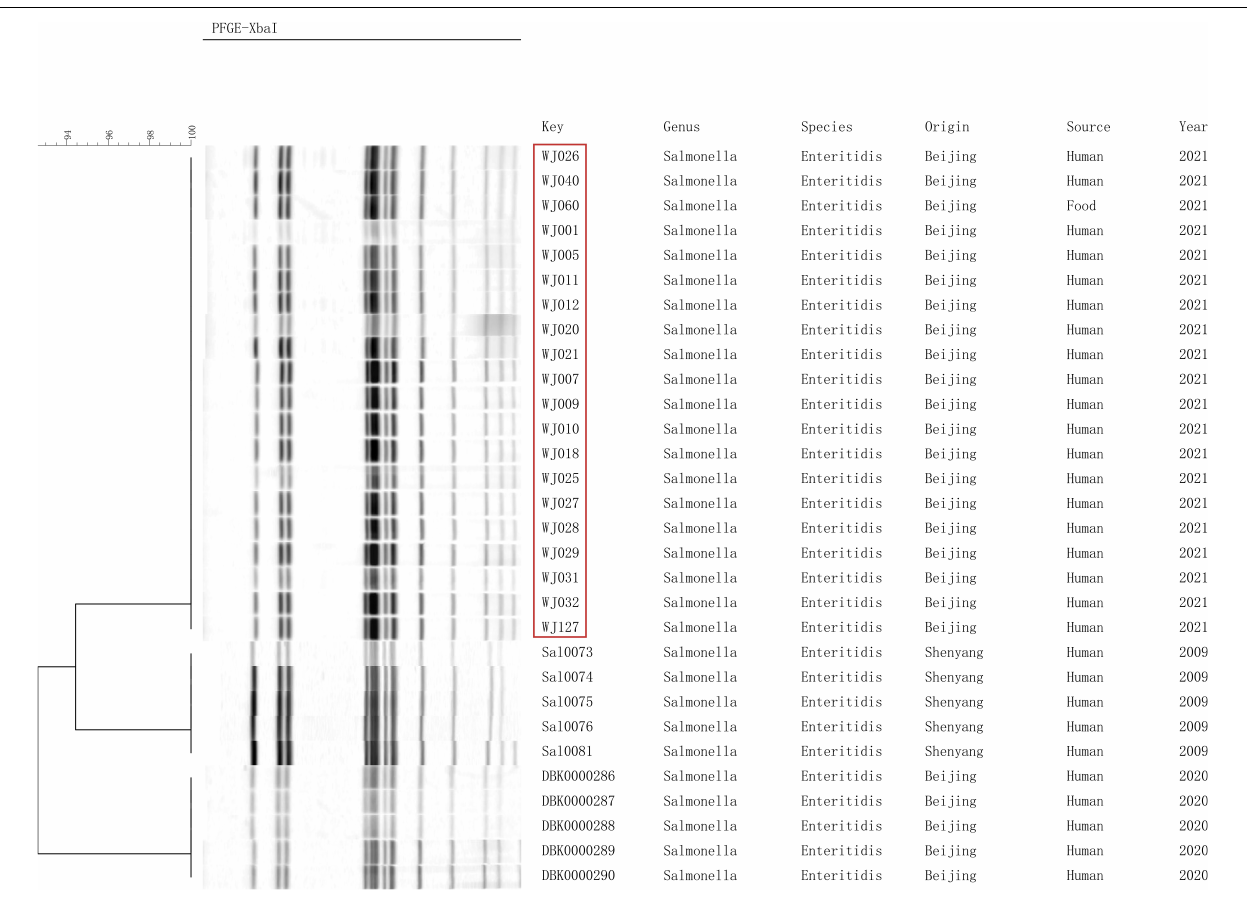
FIGURE 2 | Pulsed-field gel electrophoresis (PFGE) patterns created by digestion with the enzyme Xba